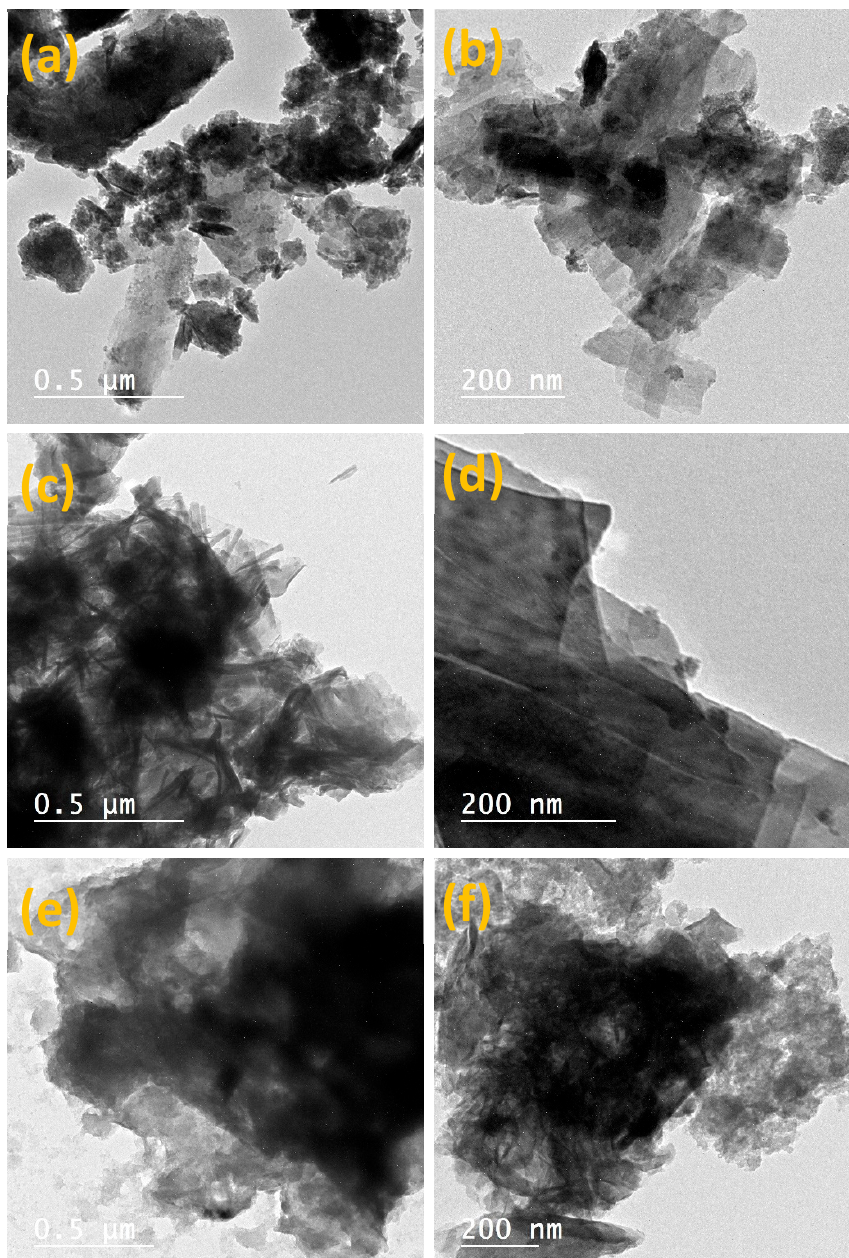
Figure 3. HR-TEM images of ( a ) ZnFe-LDH, ( b ) ZnFe-LDH/CX, ( c ) CoFe-LDH, ( d ) CoFe-LDH/CX, ( e ) NiFe-LDH, and ( f ) NiFe-LDH/CX.